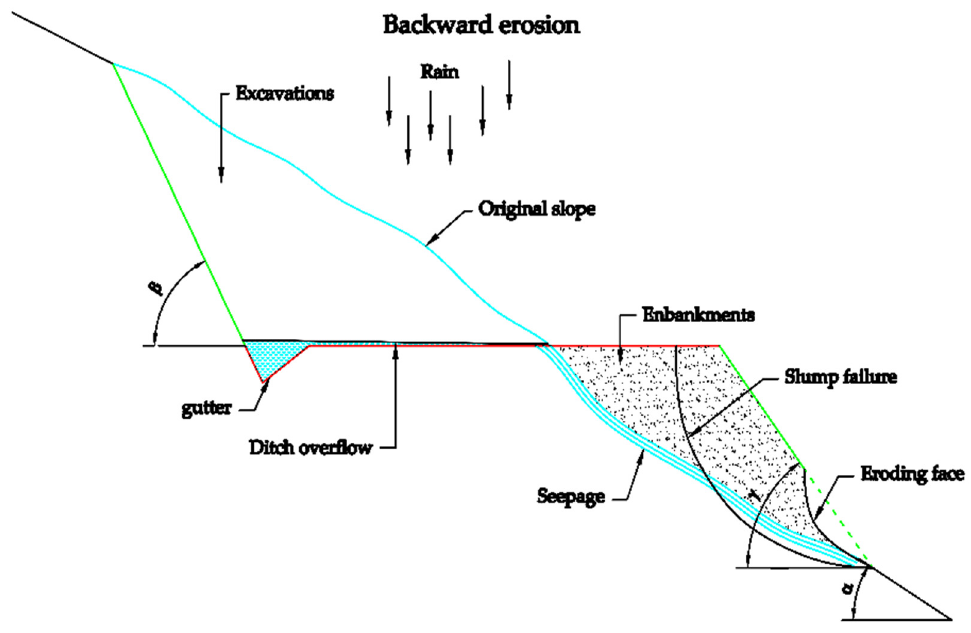
Figure 15. Draining excess water to prevent landslides.